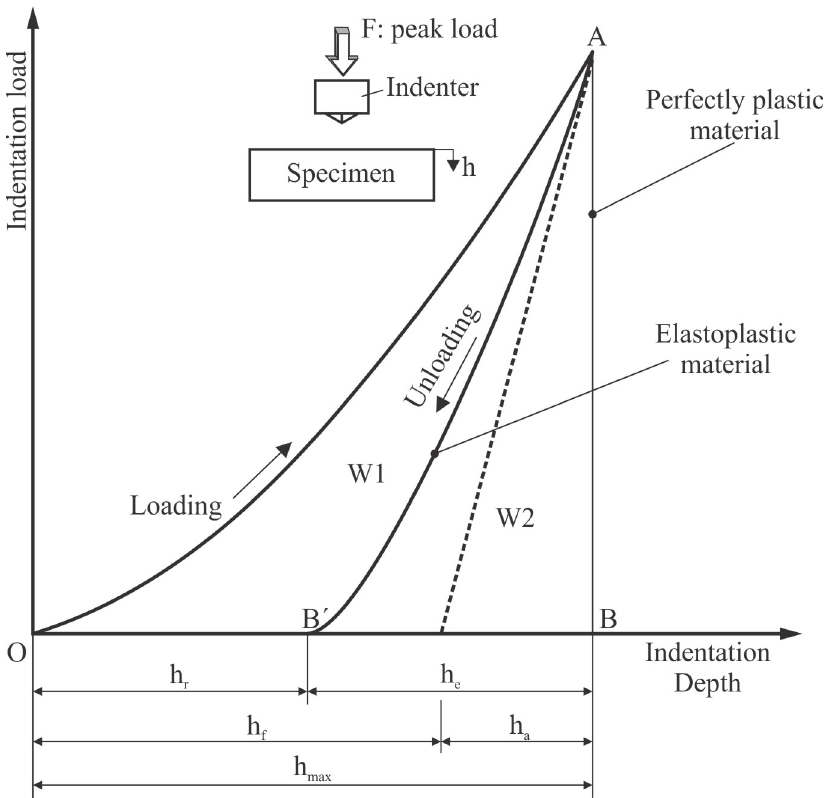
Figure 1. Schematic of nanoindentation load-depth curve of an elastoplastic material, where h max is the maximum depth, h e is the elastic depth rebound, h r is the residual impression depth, h a is the displacement of the surface at the perimeter, and h f is the contact indentation